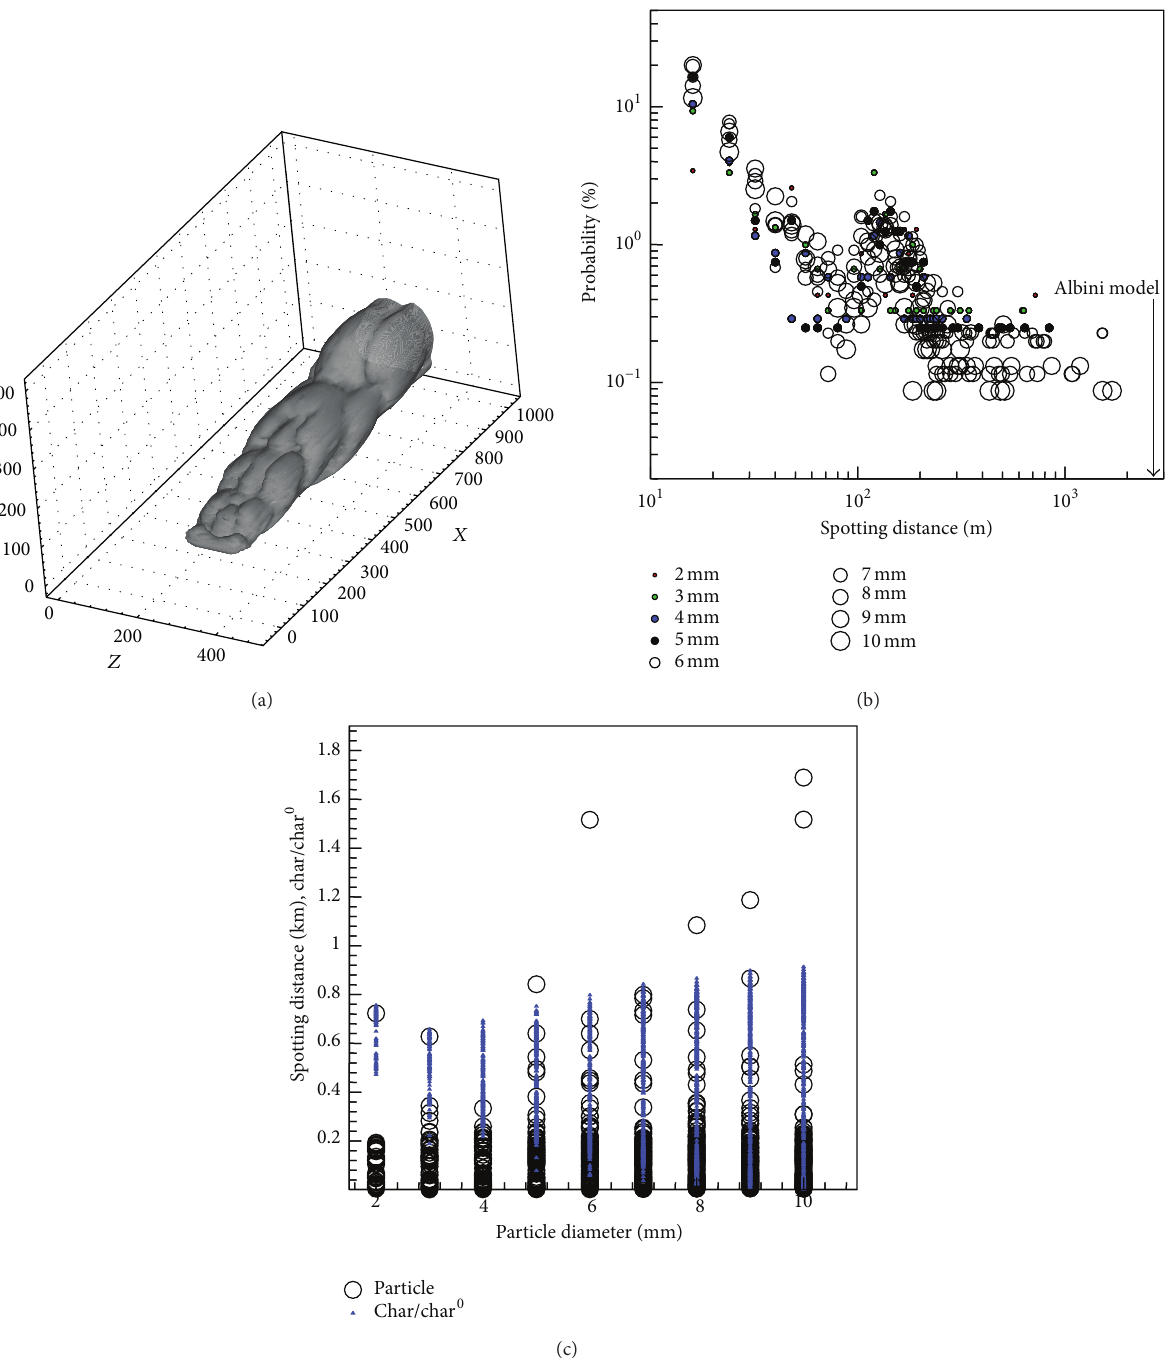
Figure 7: (a) Smoke scalar concentration for 50000 kW/m short grass fire; (b) probability of particles spotting distances as a function of particle size; and (c) particles spotting distances and char content as a function of particle